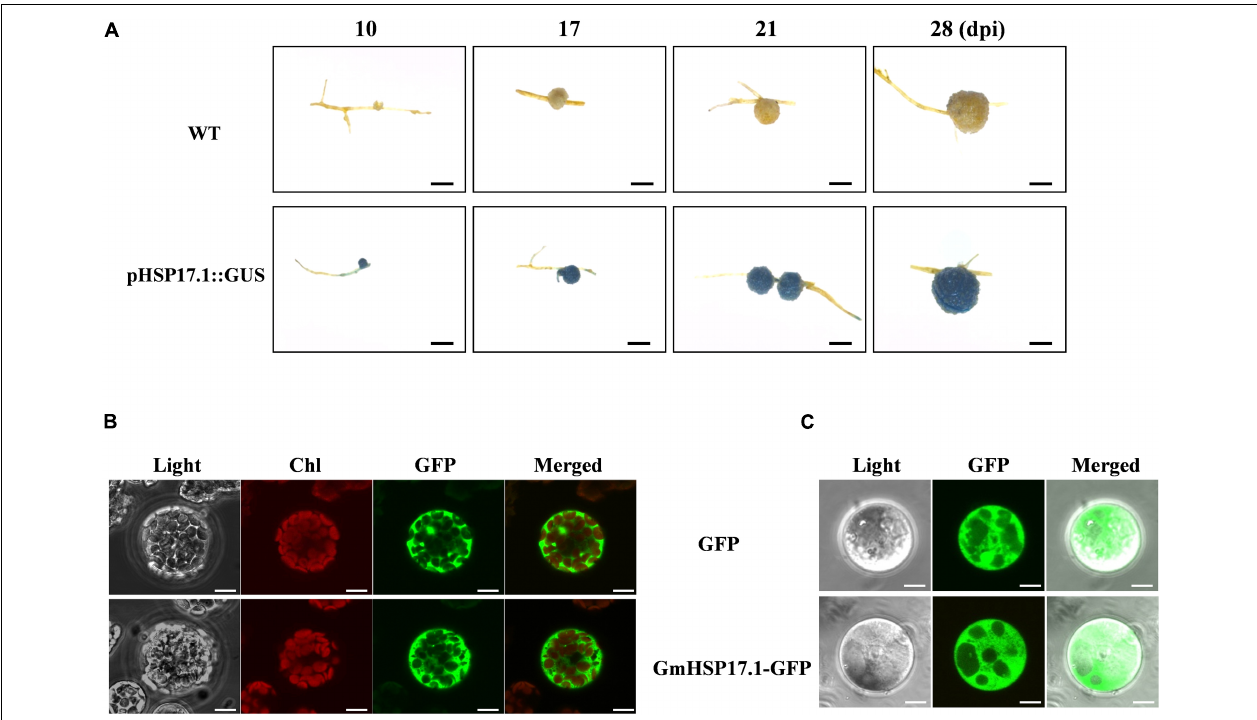
FIGURE 3 | Promoter and subcellular localization analysis of GmHSP17.1 . (A) β -glucuronidase (GUS) staining of transgenic composite soybean roots and nodules expressing pHSP17.1::GUS at different developmental stages. Three independent experiments were performed, and images from one representative experiment were shown here ( n > 10). Scale bar = 1 mm. (B) Subcellular localization of GmHSP17.1 in Arabidopsis protoplasts. GmHSP17.1-GFP construct was transformed into Arabidopsis protoplasts and green fluorescent protein (GFP) fluorescence was observed in the cytoplasm of protoplasts. GmHSP17.1-GFP: GmHSP17.1 was fused with GFP. Scale bars = 10 µ m. (C) Subcellular localization of GmHSP17.1 in soybean root protoplasts. The protoplasts were isolated from transgenic hair roots overexpressing GmHSP17.1-GFP. GFP fluorescence was observed by a confocal fluorescence microscope. The free GFP (empty vector) was used as control. Scale bars = 5 µ